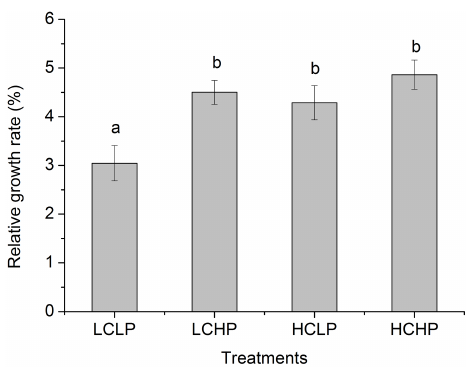
Figure 1. Relative growth rate (RGR) of S. muticum grown at differ- ent p CO 2 and P conditions for 13 days. Data are reported as means ± SD ( n = 3). LCLP is the low p CO 2 and low P condition, LCHP is the low p CO 2 and high P condition, HCLP is the high p CO 2 and low P condition, and HCHP is the high p CO 2 and high P condition. Different letters above the error bars indicate significant differences between treatments ( P < 0 .